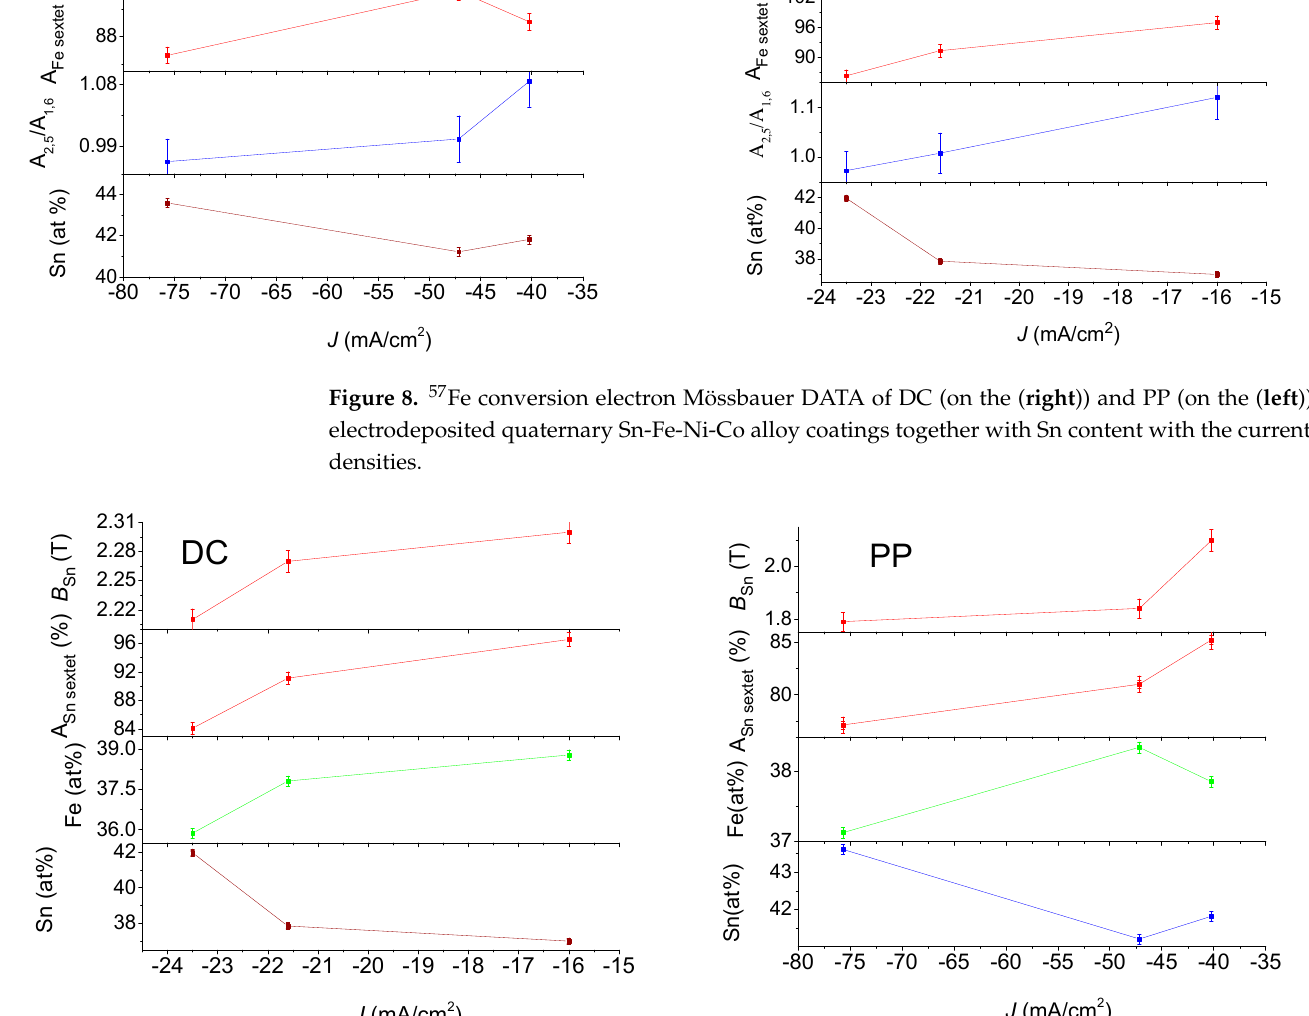
Figure 9. Variation in derived parameters from 119 Sn conversion electron Mössbauer spectra of DC (on the ( left )) and PP (on the ( right )) electrodeposited quaternary Sn-Fe-Ni-Co alloy coatings together with Sn and Fe content with the current densities.